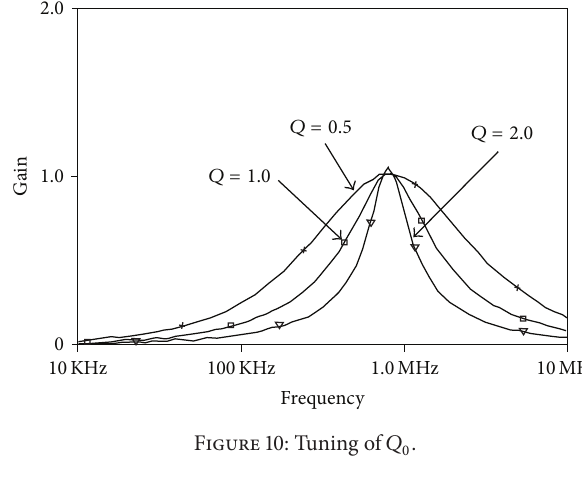
Figure 10: Tuning of 𝑄 0 .